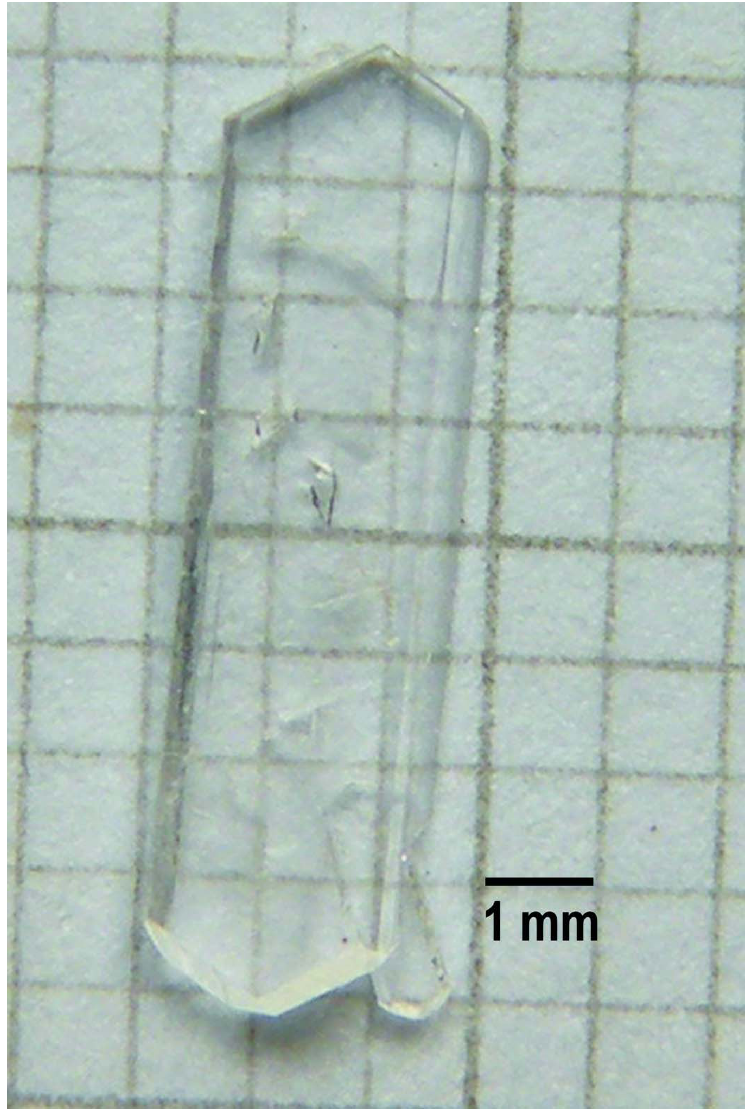
Figure 1 Crystals of [Mg(H